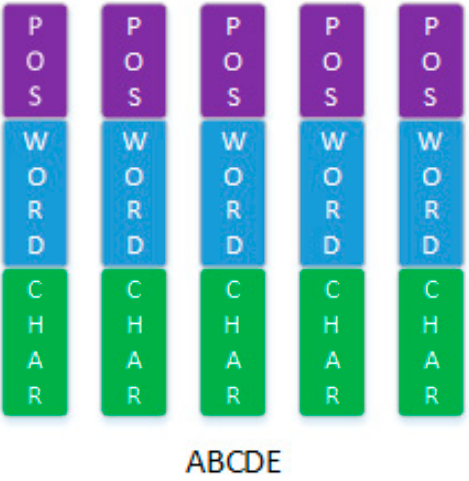
Figure 2. To facilitate the explanation of comprehensive-embedding, we assume sentence “ABCDE” is a Chinese sentence. Suppose sentence “ABCDE” can become “AB/CD/E” after the word segmentation. AB, CD, E are Chinese words after the word segmentation. This sentence consists of